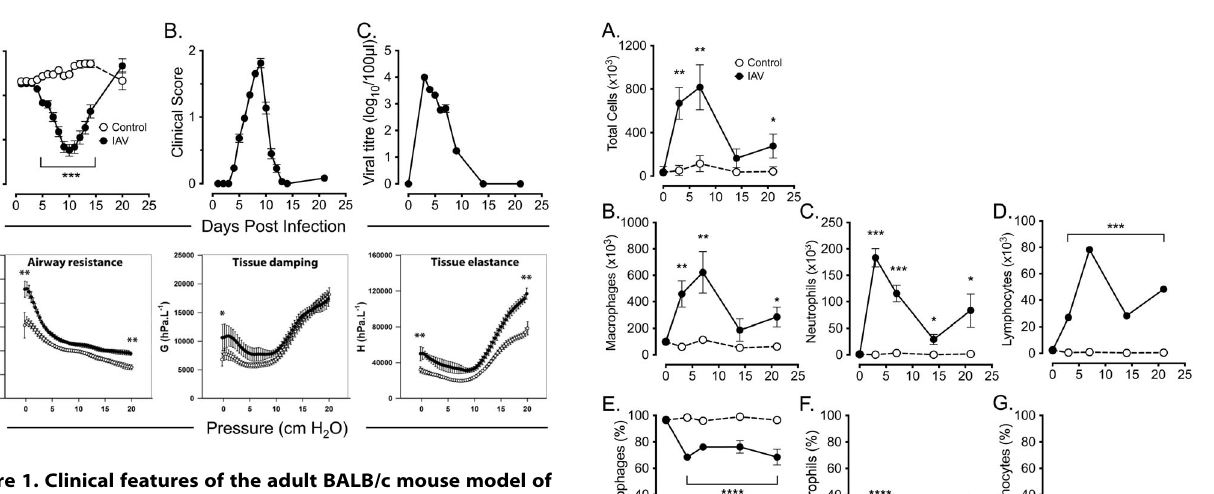
Figure 1. Clinical features of the adult BALB/c mouse model of A/PR8/34 H1N1 influenza A virus (IAV) infection. Eight week-old female BALB/c mice were inoculated i.n. with 1 6 10 2 TCID 50 A/PR/8/34 influenza A virus (IAV) in PBS and assessed at the indicated time points over the following 21 days for (A) body weight (B) clinical score and (C) lung tissue viral titres. Data are mean + / 2 SEM of groups of 20 to 60 mice per time point for weight measurements and clinical score, and 5 mice per time point for lung viral titres. Control mice received equivalent volumes of virus-free DMEM i.n. at day 0. (D) Measurement of airway resistance, tissue damping and tissue elastance at transre- spiratory pressure during slow inflation manoeuvres up to 20cm H 2 O in influenza infected mice (closed circles) and controls (open circles) at day 4 post infection. Influenza infected mice had impairments in Raw, G and H. Asterisks indicate statistical significance of IAV infected as compared to control mice as described in Materials and Methods. Data are means + / 2 SEM of 4 mice per group. * = p , 0.05; ** = p , 0.01; *** = p , 0.001.